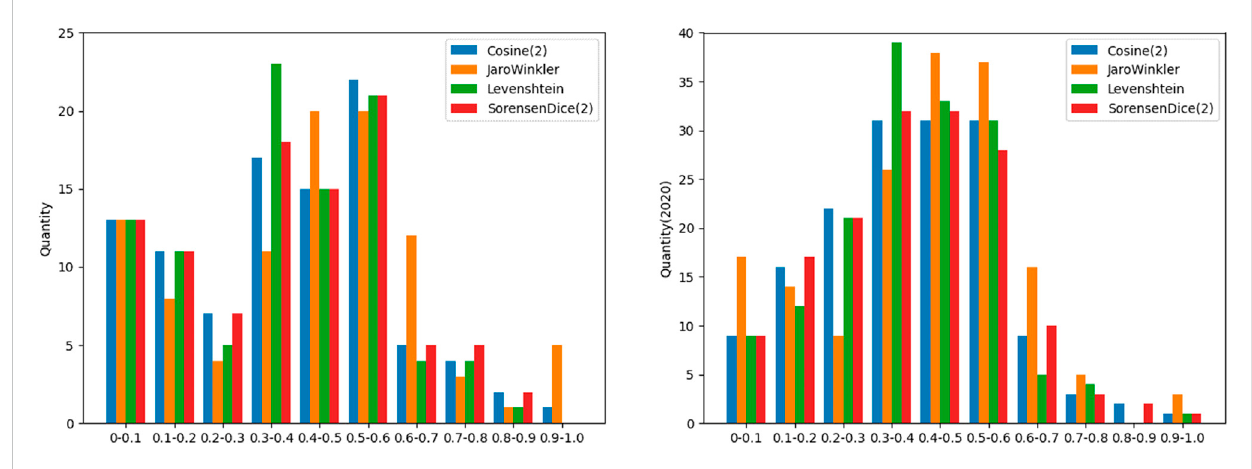
FIGURE 6 Correction similarity with distance methods.